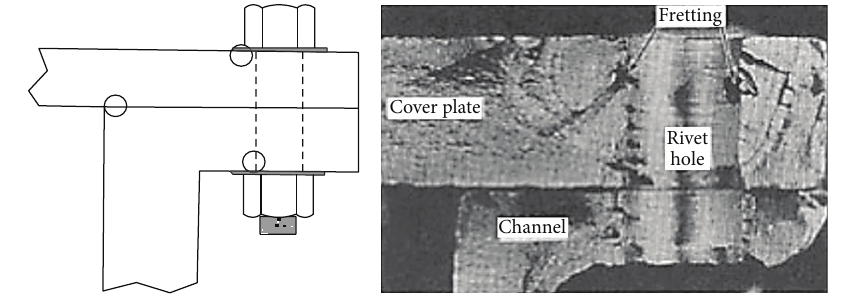
Figure 2: Fretting fatigue in bolted flanges [11].